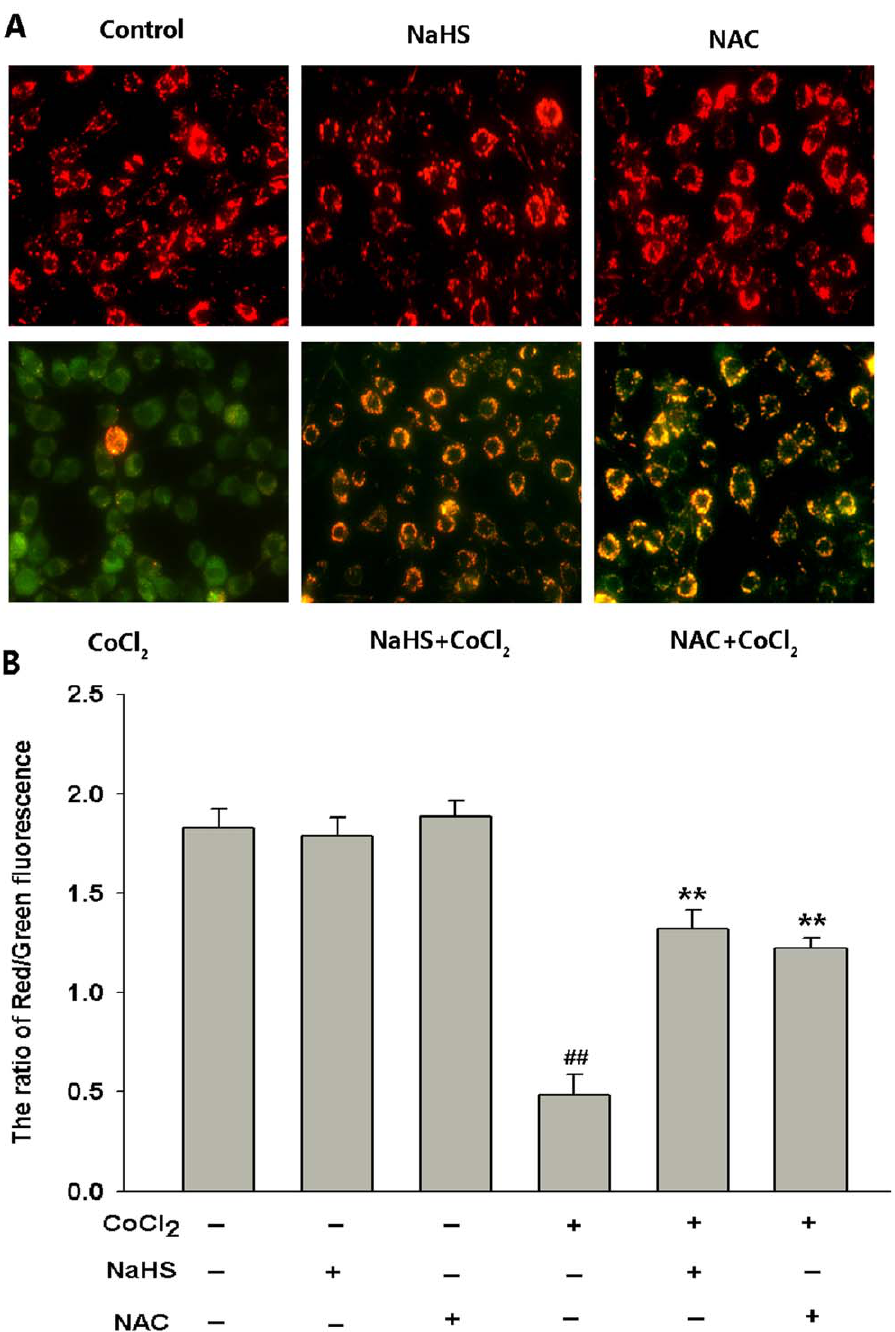
Figure 12. H 2 S and NAC protected PC12 cells against CoCl 2 -induced mitochondrial insult. MMP was assessed by JC-1 staining . Dual emission images (527 and 590nm) represent the signals from monomeric (green) and J-aggregate (red) JC-1 fluorescence in PC12 cells. (A) Control, untreated cells; NaHS, cells were treated with 400 m mol/L NaHS for 30 min alone; NAC, cells were treated with 500 m mol/L NAC for 60 min alone;